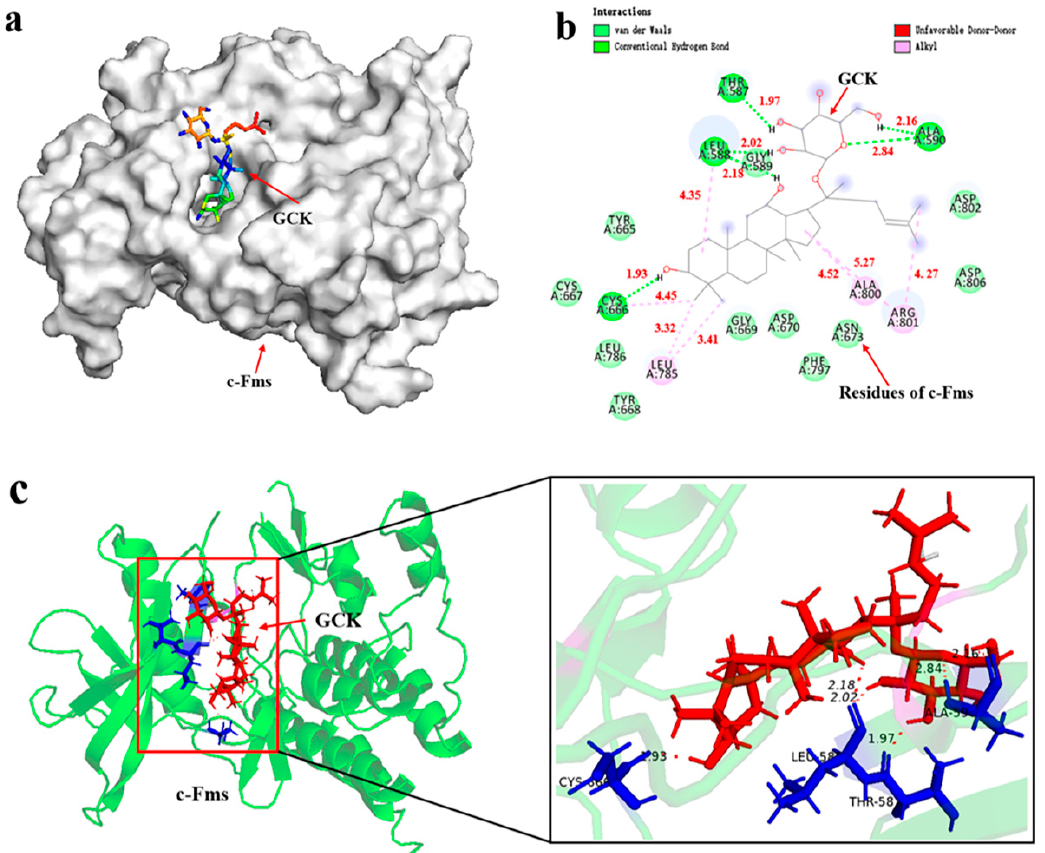
Figure 9. Molecular docking of c-Fms and GCK ( a ): diagram of molecular GCK located on the cavy of the c-Fms protein surface; ( b ): GCK-c-Fms interactions on a 2D diagram; ( c ): hydrogen bond interactions between GCK and amino acid residues of c-Fms on a 3D diagram.